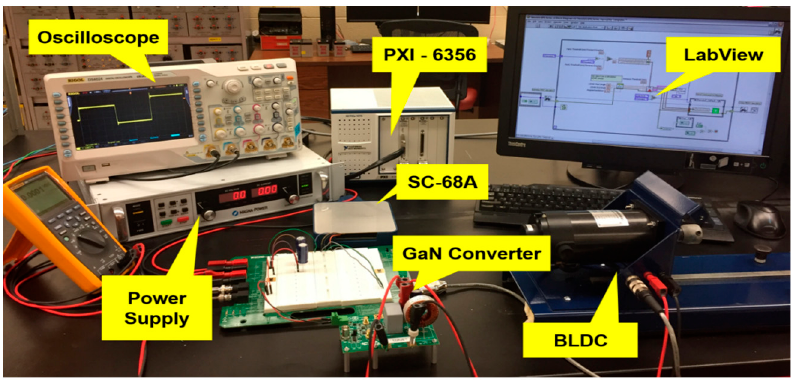
Figure 8. Experimental setup of the proposed system.